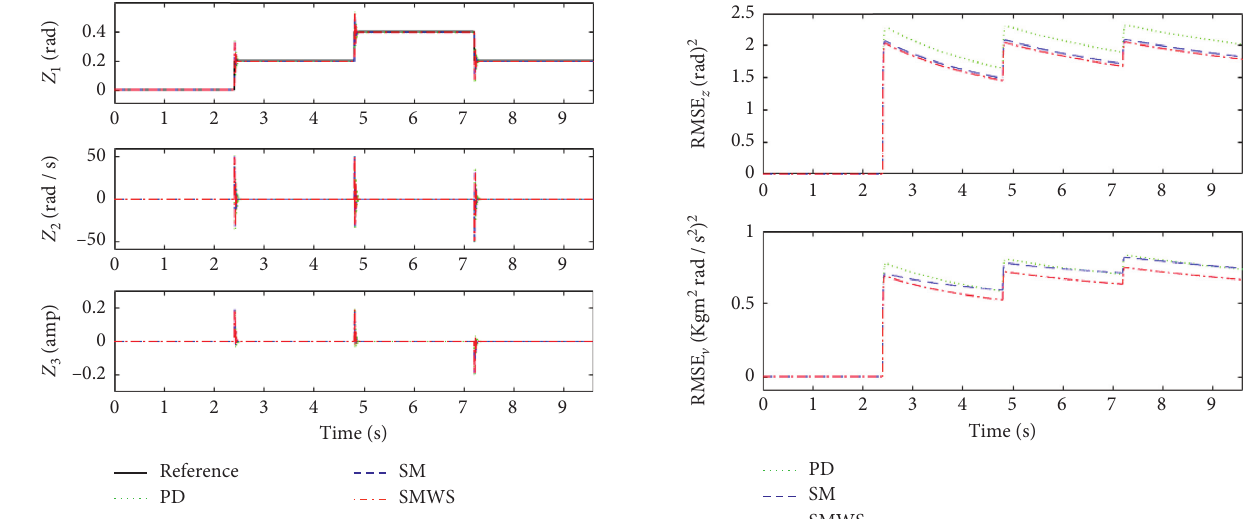
Figure 6: States of the first electricity generator.